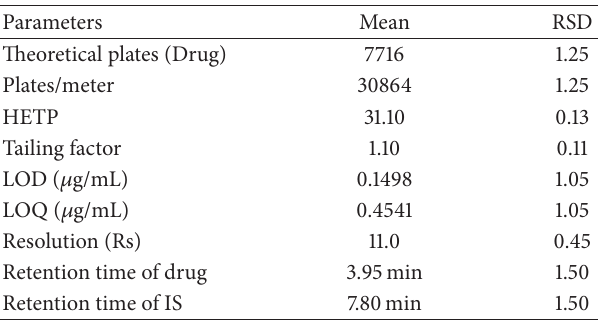
Table 4: System suitability.